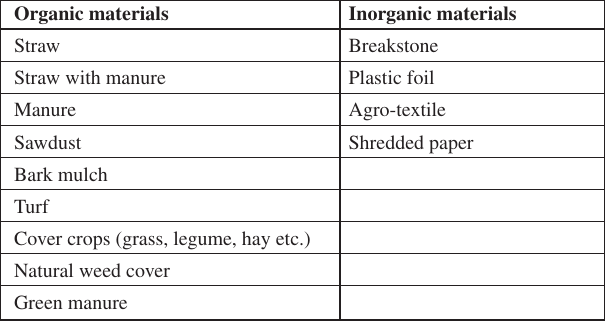
Table 1. Commonly used mulching